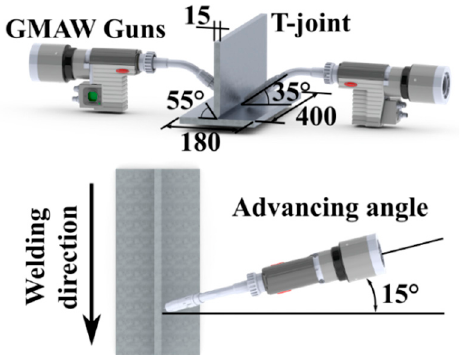
Figure 3. Schematic diagram of T-joint double-sided GMA welding.